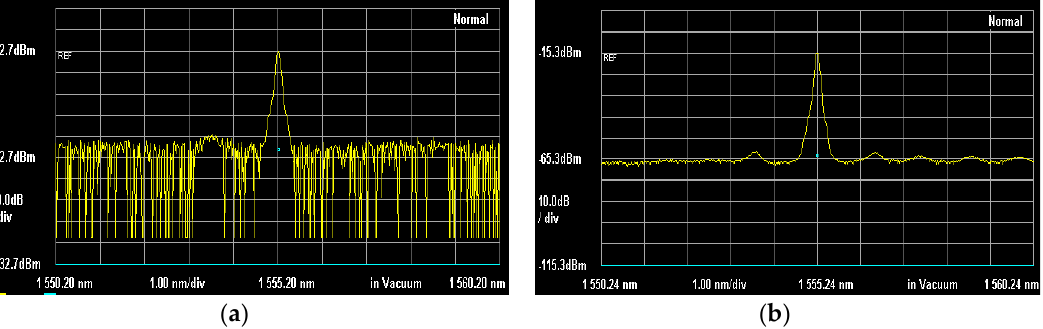
Figure 12. The sample of the signal spectral measurement at 1555.2 nm from the output of DD and the OSF. ( a ) The received signal for DD without implementing an OSF; and ( b ) the signal spectral measurement produced by the OSF. Both are under a strong turbulence condition.